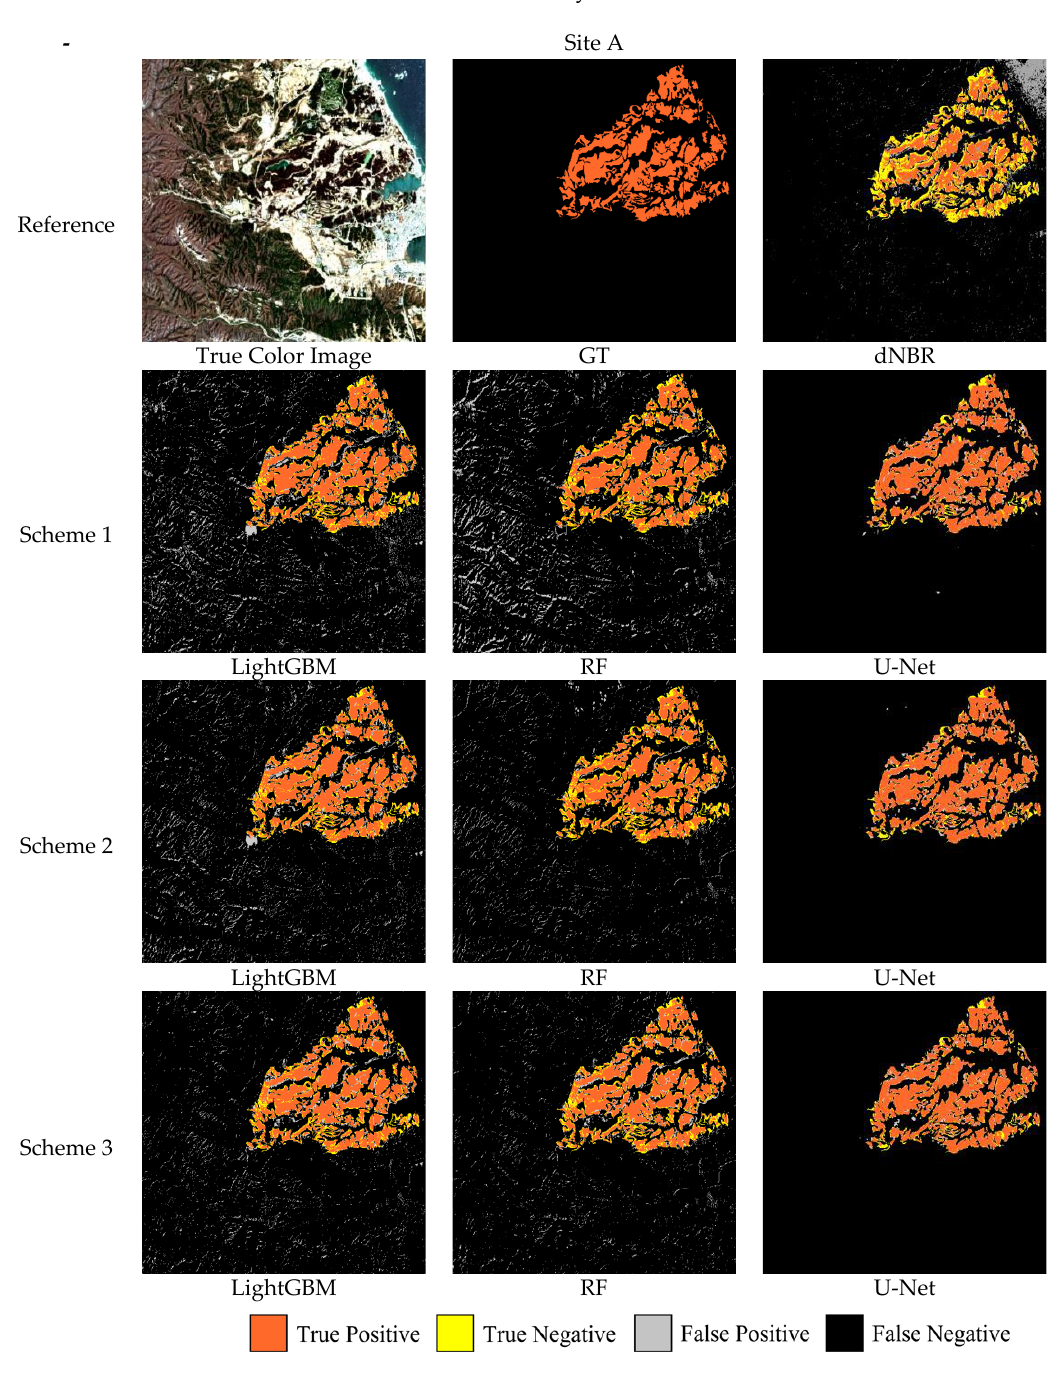
Figure 7. Visualization of burned area detection errors in Site A.